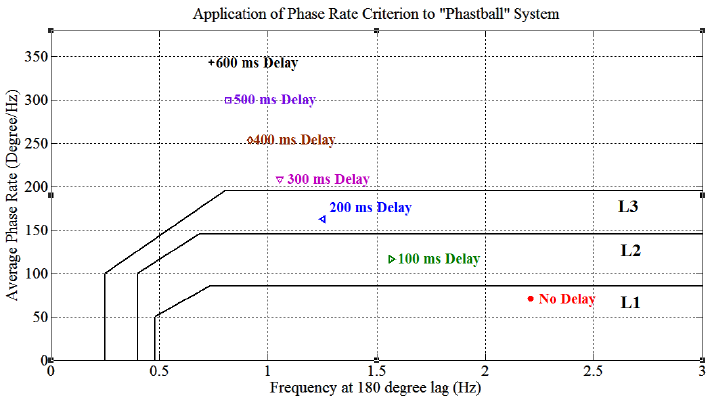
Figure 6. Phase rate criterion applied to “Phastball” system.